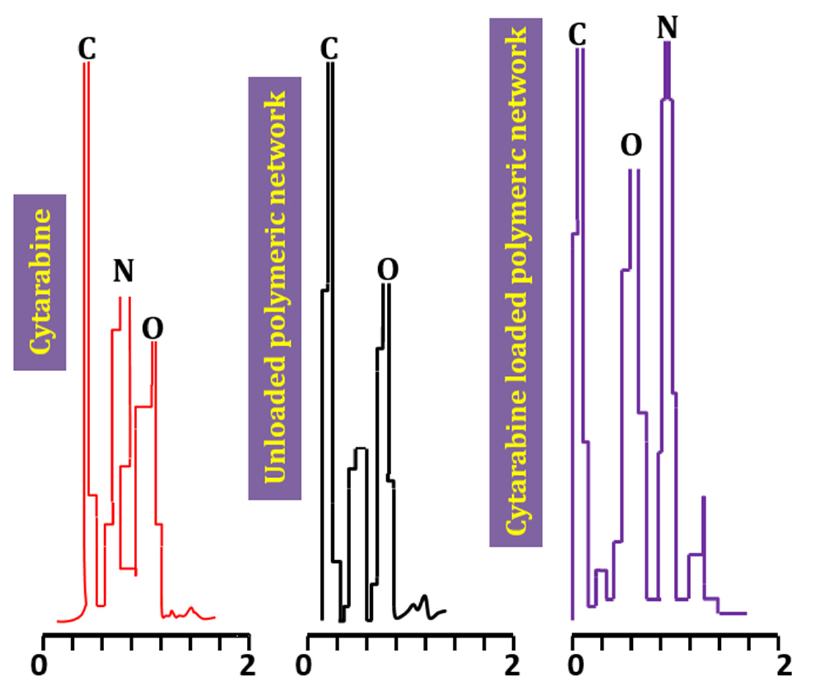
Figure 2. EDX spectra of pure drug, Unloaded hydrogels and loaded hydrogels.